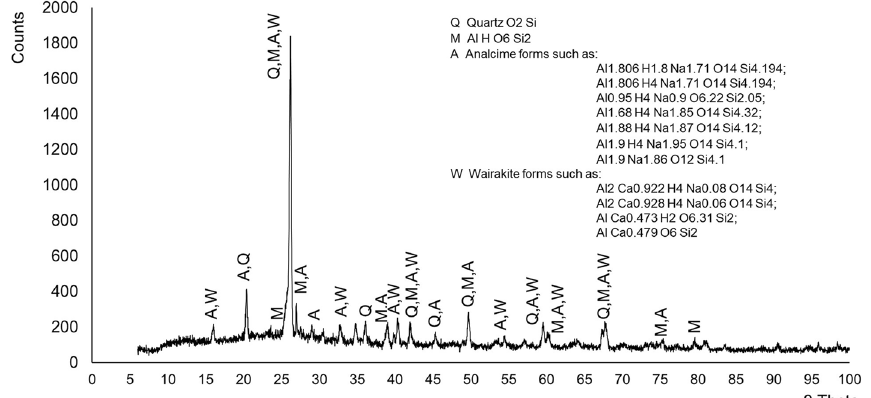
Fig. 8 X-ray diffraction analysis test results for fly ash geopolymer mortar (i.e., 0% lime content) after thermal curing of 70 °C for 2